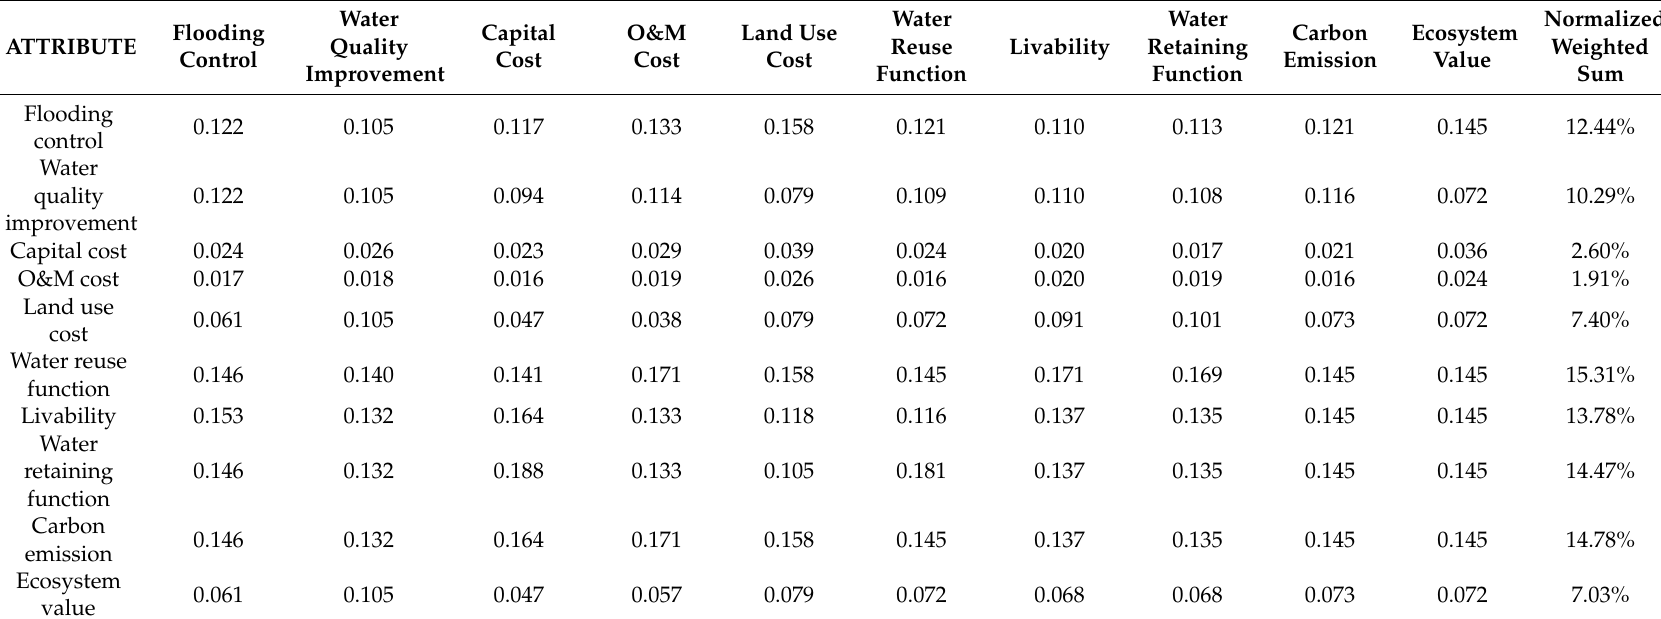
Table A11. Obtaining the results by